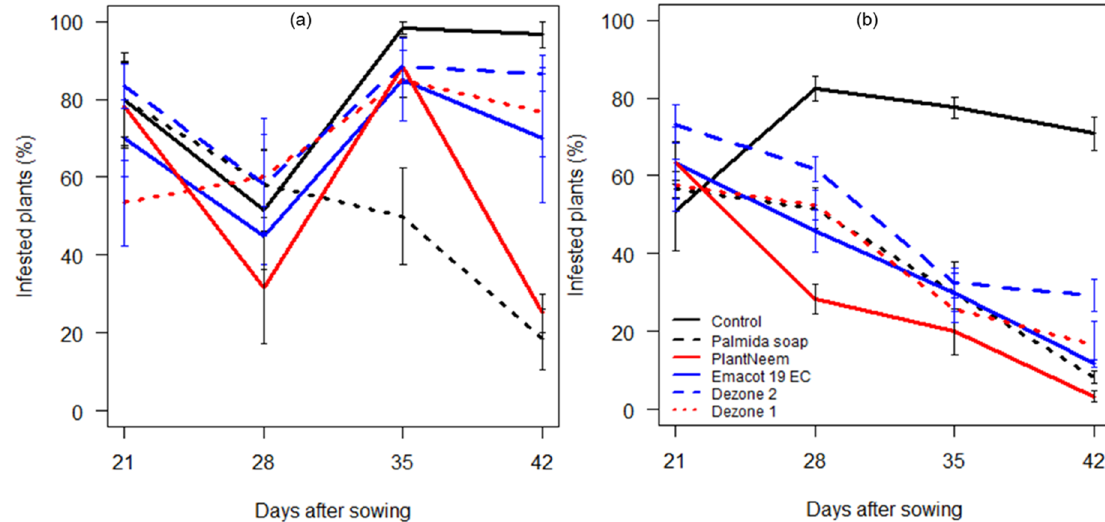
Figure 2. Percentage of plants harboring Spodoptera frugiperda larvae based on weekly observations of 15 maize plants per plot at Adjohoun ( a ) and 30 plants at N’Dali ( b ) on each collection date. The treatments included Palmida soap, PlantNeem, Emacot 19 EC, Dezone, and the untreated control. Dezone 1 and 2 refer to application rates of 7.5 and 15 kg/ha, respectively.